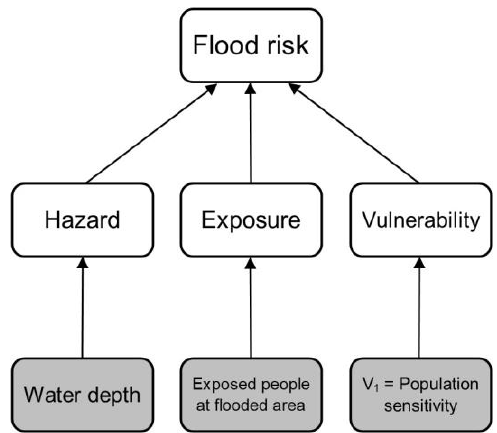
Figure 8. Flood risk model for an endangered population.